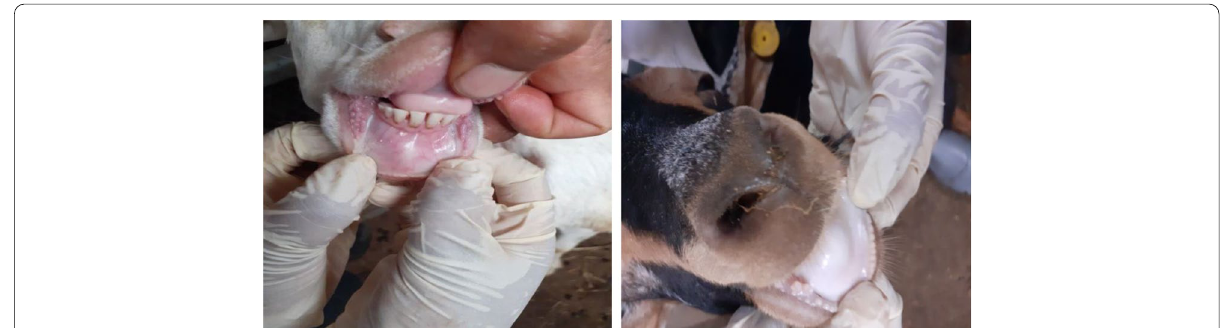
Fig. 1 Development of anemia as expressed by change in the color of the mucousmembrane: Goat with pinkish mucous membrane (left: non-infected), and pale mucous membrane (right; infected)